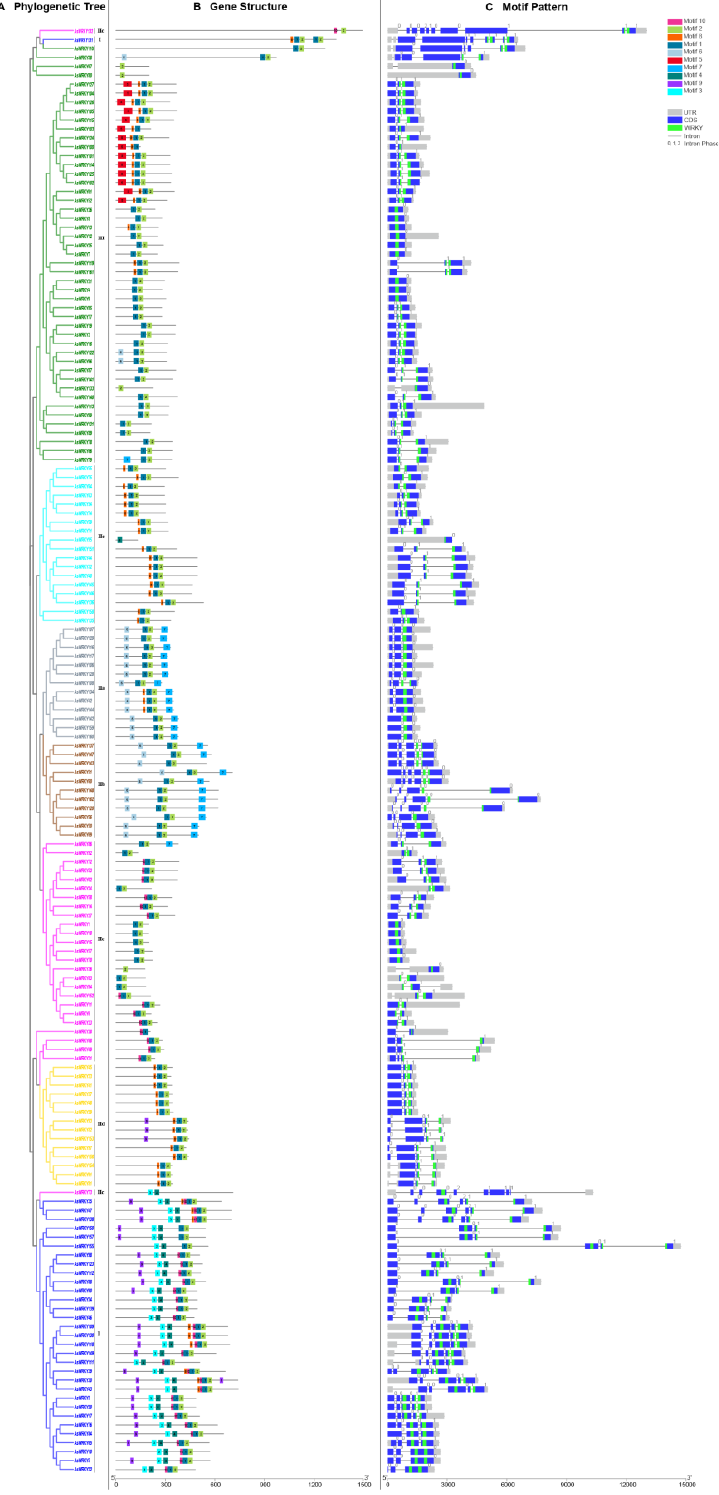
Figure 3. Phylogenetic relationship, conserved motifs and gene structure of AsWRKY proteins in oat. ( A ) The phylogenetic tree was constructed based on 162 AsWRKY full-length proteins using MEGA 7 software. ( B ) The conserved motifs, numbers 1 – 10, are shown in different colored boxes. The details of each motif provided by Figure S2. ( C ) The exon-intron structure of AsWRKY genes. Grey boxes represent 5 (cid:48) UTR and 3 (cid:48) UTR, blue boxes represent exons, greens boxes represent AsWRKY genes, and black lines present